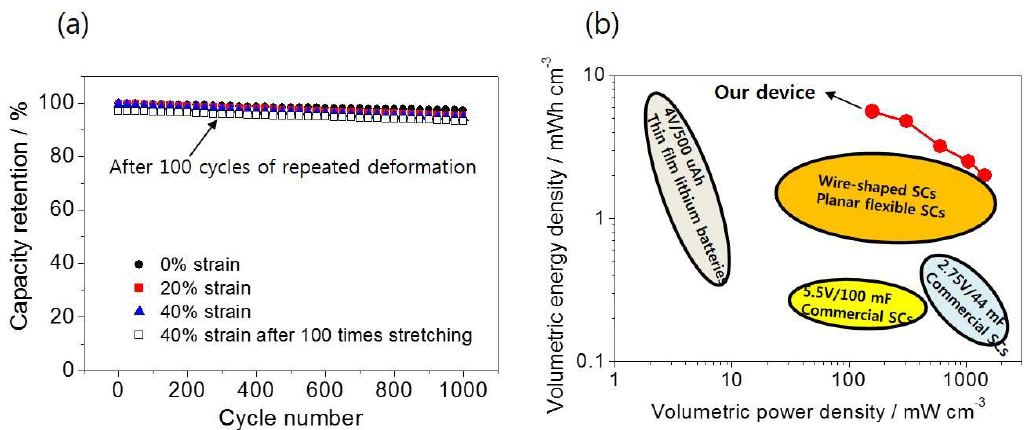
Figure 7. Long-term cycling life (without and with stretching) and Ragone plot. ( a ) Capacitance retention as a function of the number of charge/discharge cycles at a current density of 0.083 A cm −3 ; ( b ) Ragone plots (volumetric energy density vs. volumetric power density) calculated from the galvanostatic charge/discharge curves at various current densities (from 0.021 A cm −3 to 0.208 A cm −3 ).